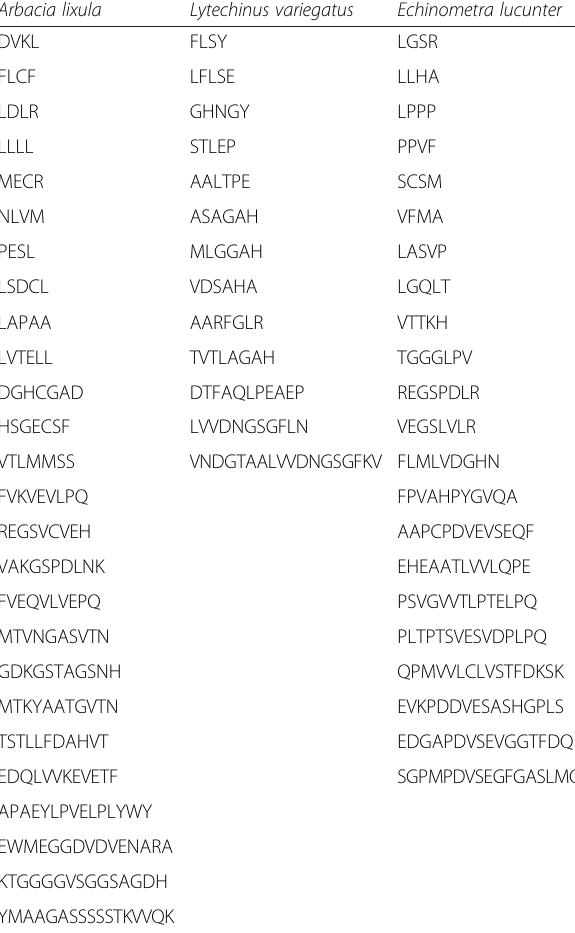
Table 1 Peptides identified and de novo sequenced in coelomic fluid of sea urchins Arbacia lixula